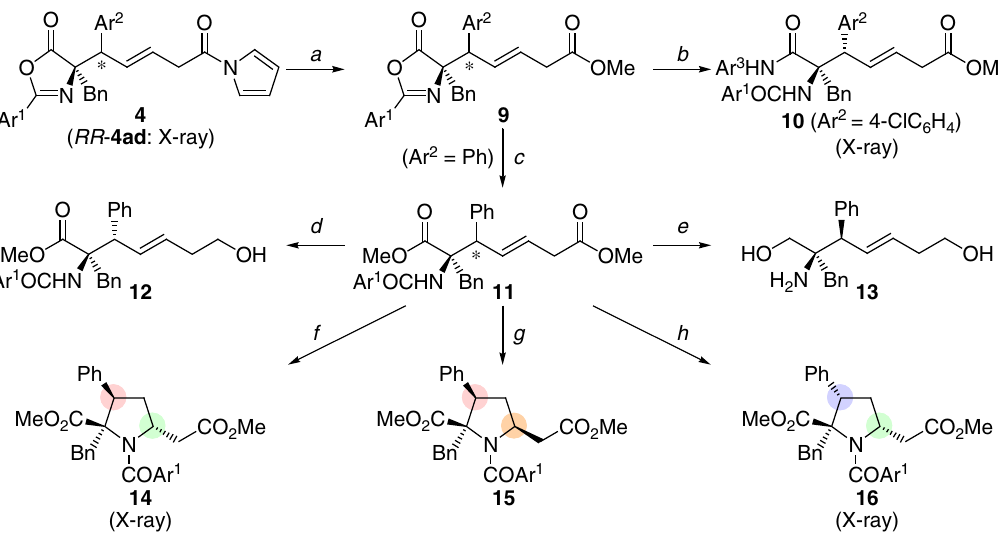
Figure 4 | Conversion to various a -tetrasubstituted a -amino acid derivatives. Conditions (Ar 1 ¼ 2,6-(MeO) 2 C 6 H 3 ): (a) NaOMe, MeOH/CH 2 Cl 2 , 0 (cid:2) C, 81% (from RS - 4ac ); 91% (from RR - 4aa ); 83% (from RS - 4aa ), (b) BF 3 (cid:4) OEt 2 , 4-ClC 6 H 4 NH 2 (Ar 3 NH 2 ), toluene, 100 (cid:2) C, 56% (from RS - 9ac ), (c) SOCl 2 , MeOH, 5 (cid:2) C, 83% (from RR - 9aa ); 69% (from RS - 9aa ), (d) LiBH 4 , THF, rt, 95% (from RS - 11 ), (e) (i) LiAlH 4 , Et 2 O, reflux, (ii) KOH, aqueous MeOH, 150 (cid:2) C (MW), 78% (2 steps from RR - 11 ), (f) PtCl 2 , Cs 2 CO 3 , DMF, 140 (cid:2) C, 76% (pure diastereomer, see Supplementary Fig. 103) (from RR - 11 ), (g) DBU, MeOH, 40 (cid:2) C, 54% (pure diastereomer) (from RR - 11 ), (h) DBU, MeOH, 60 (cid:2) C, 88% (diastereomeric mixture, dr ¼ 14:1, see Supplementary Fig. 104 for the absolute stereochemistry of major isomer) (from RS - 11